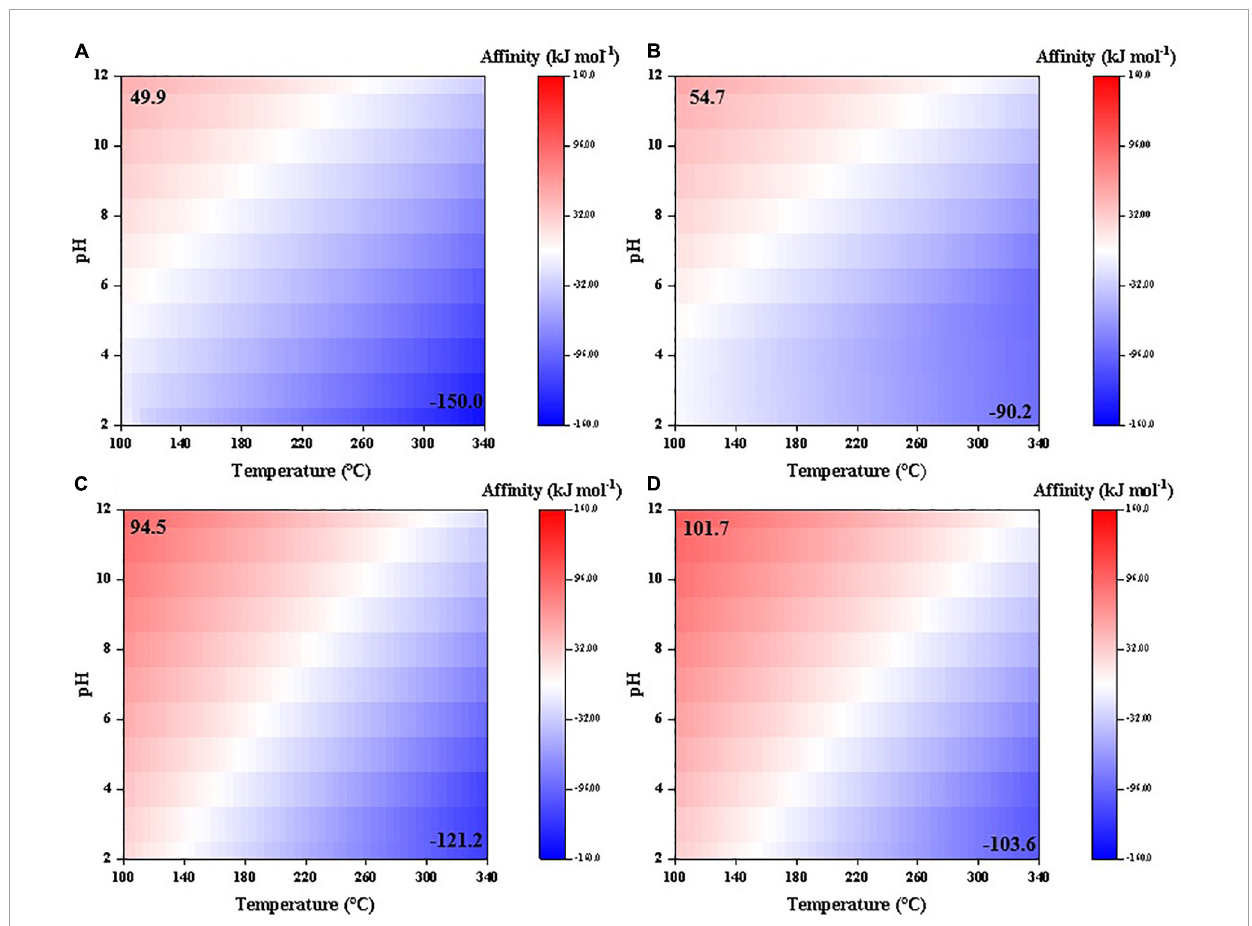
FIGURE4 Synthesis affinity of glycolic acid [CH 2 OHCOOH, aq + CH 2 OHCOO - ; (A,B) ] and pyruvic acid [CH 3 COCOOH, aq + CH 3 COCOO - ; (C,D) ] using (A,C) CO, g and (B,D) CO 2 , g as the carbon source.